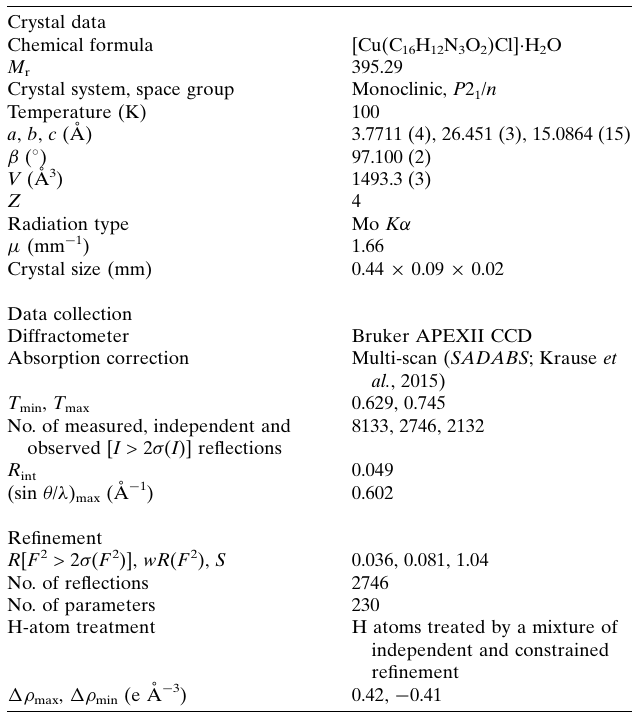
Table 2 Experimental